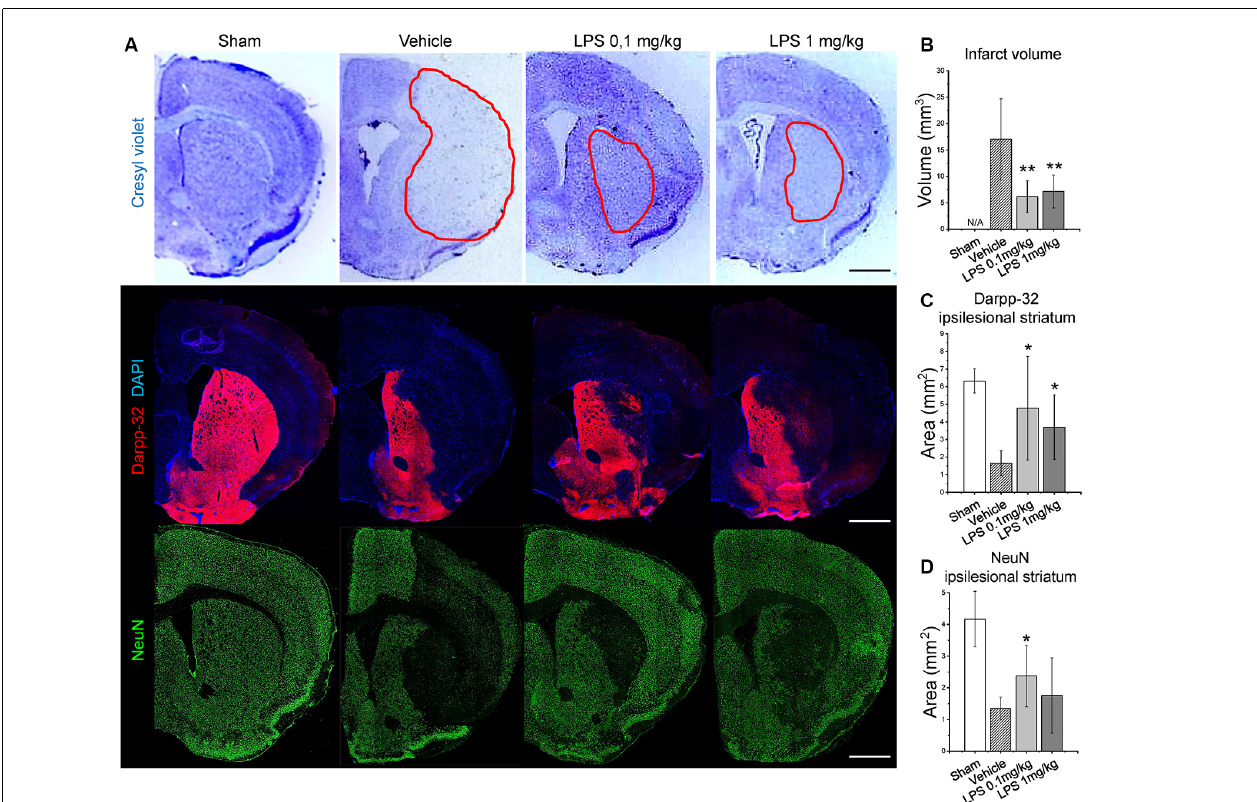
FIGURE 2 | Post-ischemic LPS delivery dose-independently reduces infarct volume and increases neuronal survival. Panel (A) shows representative cresyl violet (infarcted tissue outlined), Darpp-32 and neuronal nuclei (NeuN) staining in the ipsilesional striatum of mice exposed to sham surgery or intraluminal MCAO which were intraperitoneally treated with vehicle or LPS (0.1 or 1 mg/kg) at 24 h after MCAO. Quantifications of infarct volume (B) , Darpp-32+ neurons in the ipsilesional striatum (C) and NeuN+ neurons (D) are provided. Data are means ± SD values. * p < 0.05/** p < 0.01 compared with vehicle group ( n = 6 animals/group). Scale bars, 1 mm.